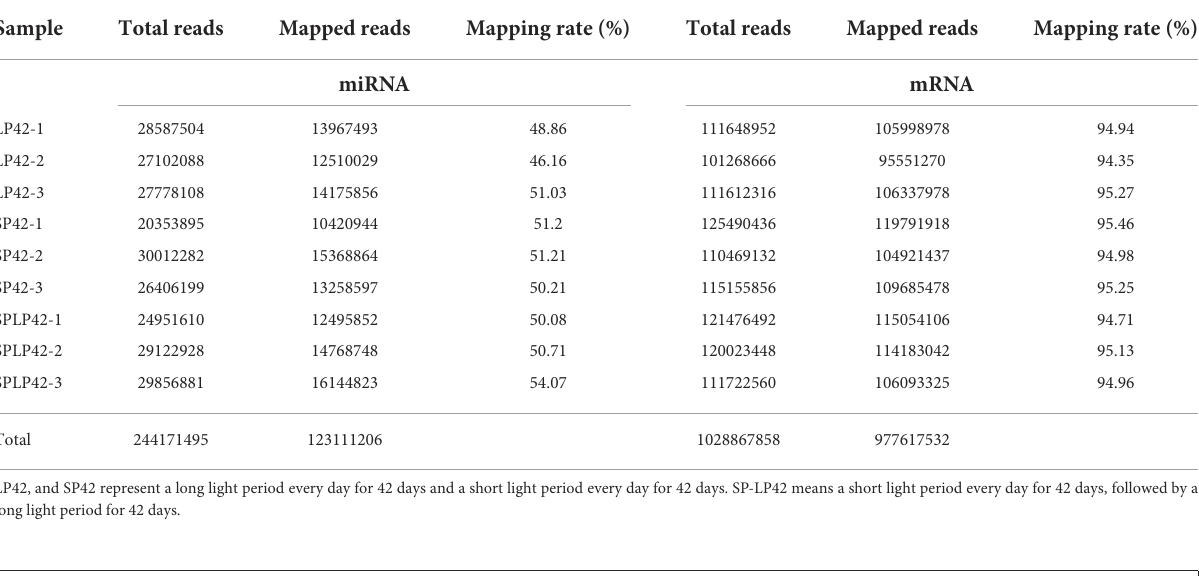
TABLE 1 Summary of the mapping data from the adrenal gland tissues.